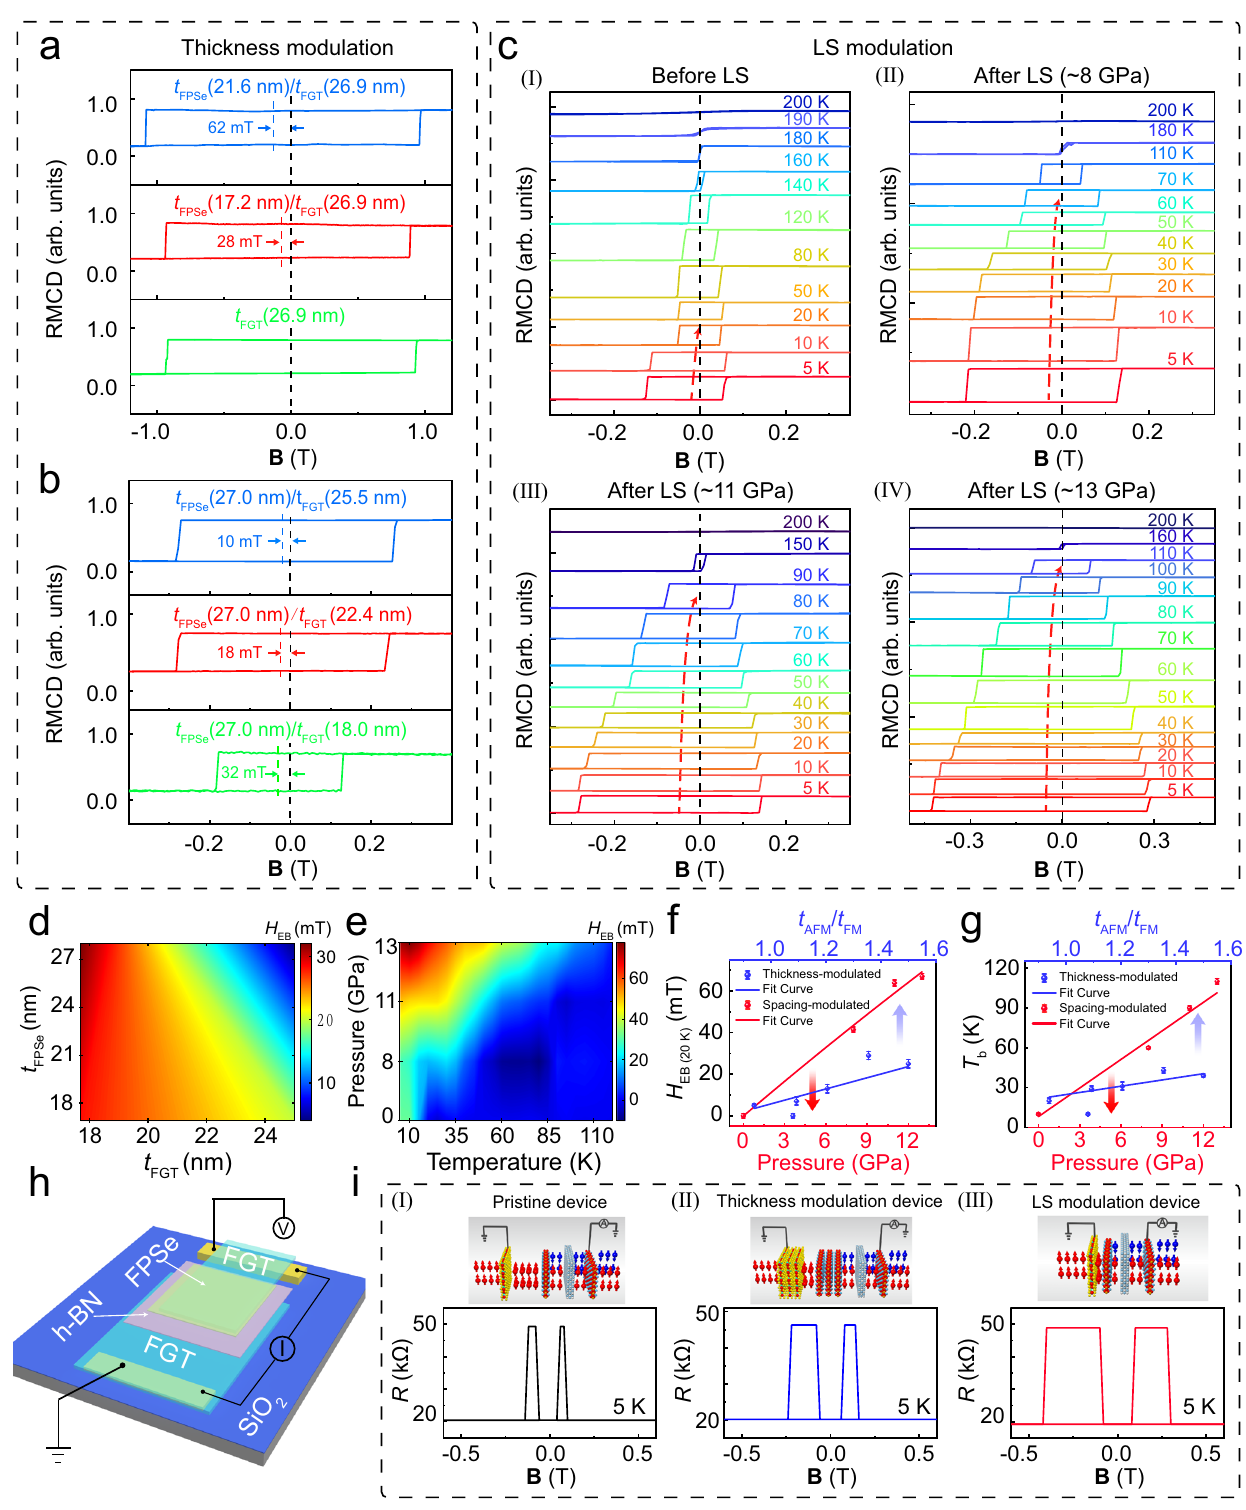
Fig. 3 | Comparison of interlayer spacing-modulation and thickness- modulation.a KerrloopsforindividualFGT(26.9nm)andFPSe(17.2nm,21.6nm)/ FGT (26.9nm) heterostructures, respectively, measured at 5K. b Kerr loops for individual FPSe (27.0nm)/FGT (18.0nm, 25.5nm, and 22.4nm) heterostructures, respectively, measured at 5K. c The temperature-dependent Kerr loops of FPSe/ FGT heterostructures are measured under 0 Gpa, ~8 Gpa, ~11 Gpa, and ~13 Gpa at 5K,respectively. d Theevolutionof H EB on t FGT and t FPSe . e Theevolutionof H EB on temperature and pressure before and after LS. f , g The evolution of H EB and T b on